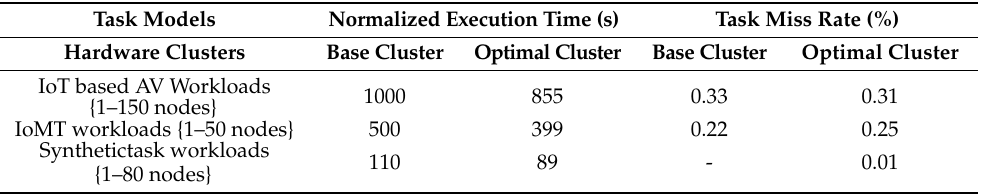
Table 8. Normalized Execution time obtained for synthetic and AV workloads on Hardware configu- ration